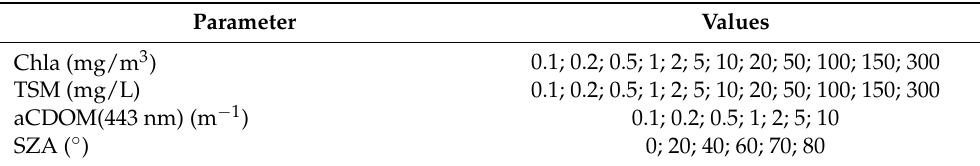
Table 1. Setup for the HydroLight simulations. Parameter